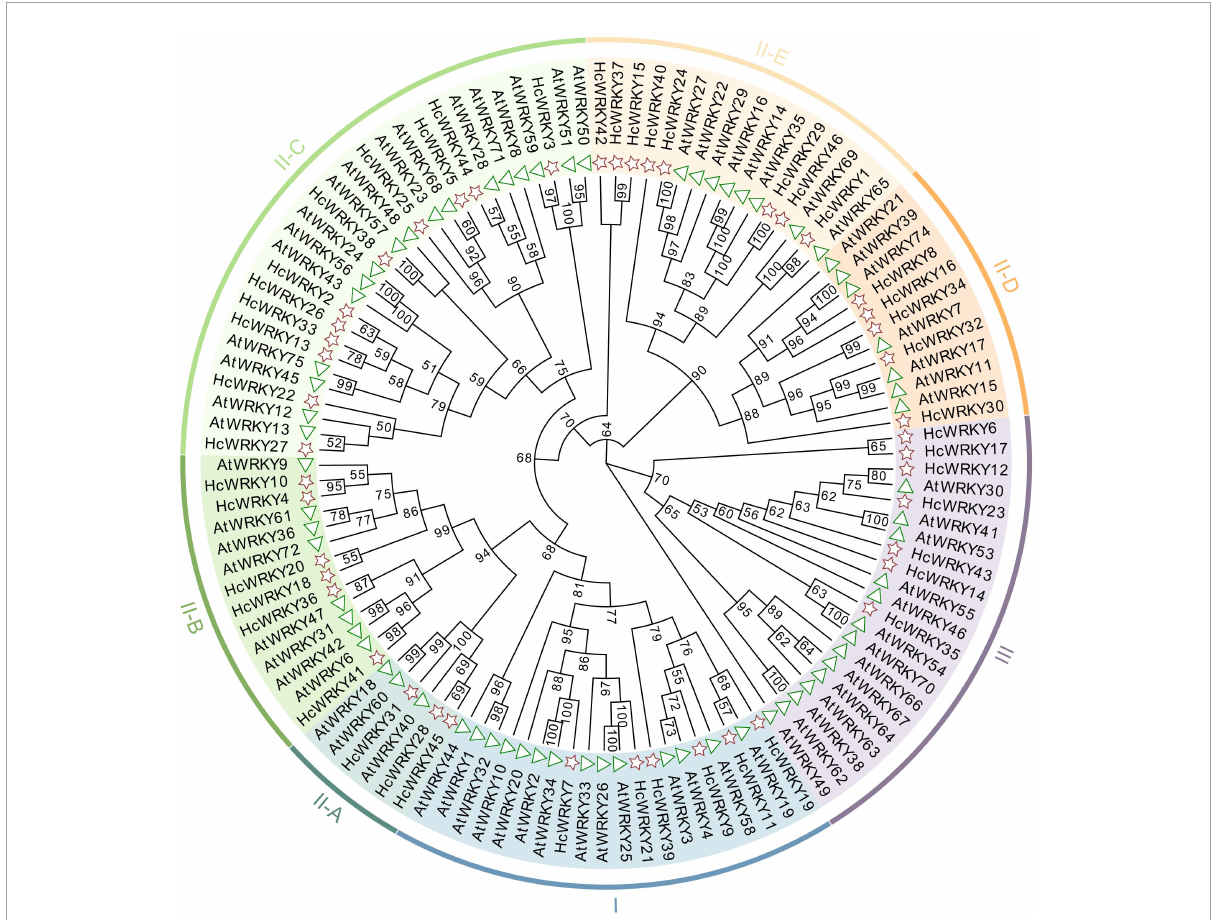
FIGURE1 Phylogenetic tree analysis revealed the relationship of WRKY genes between kenaf and Arabidopsis . The unrooted phylogenetic tree was generated by the MEGA7.0 software using the neighbor-joining method, with bootstrap value was 1000 replicates. The different color arcs represent different groups and/or subgroups of WRKY genes. AtWRKY genes were represented by triangle, and HcWRKY genes were